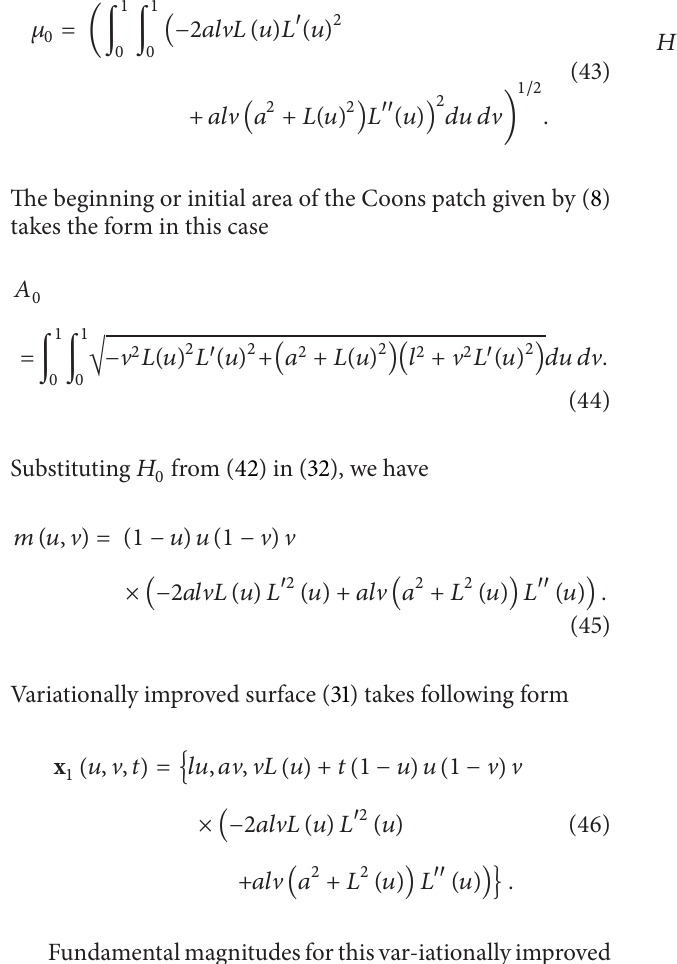
The root mean square (rms) of beginning curvature given